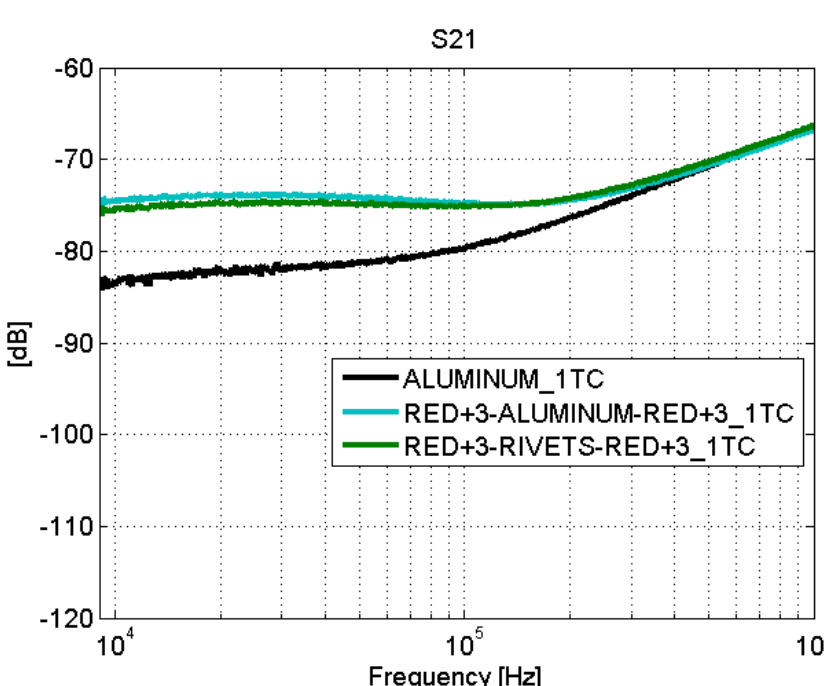
Figure 16. Surface current test: S 21 . Fastener joints. Line 1T.